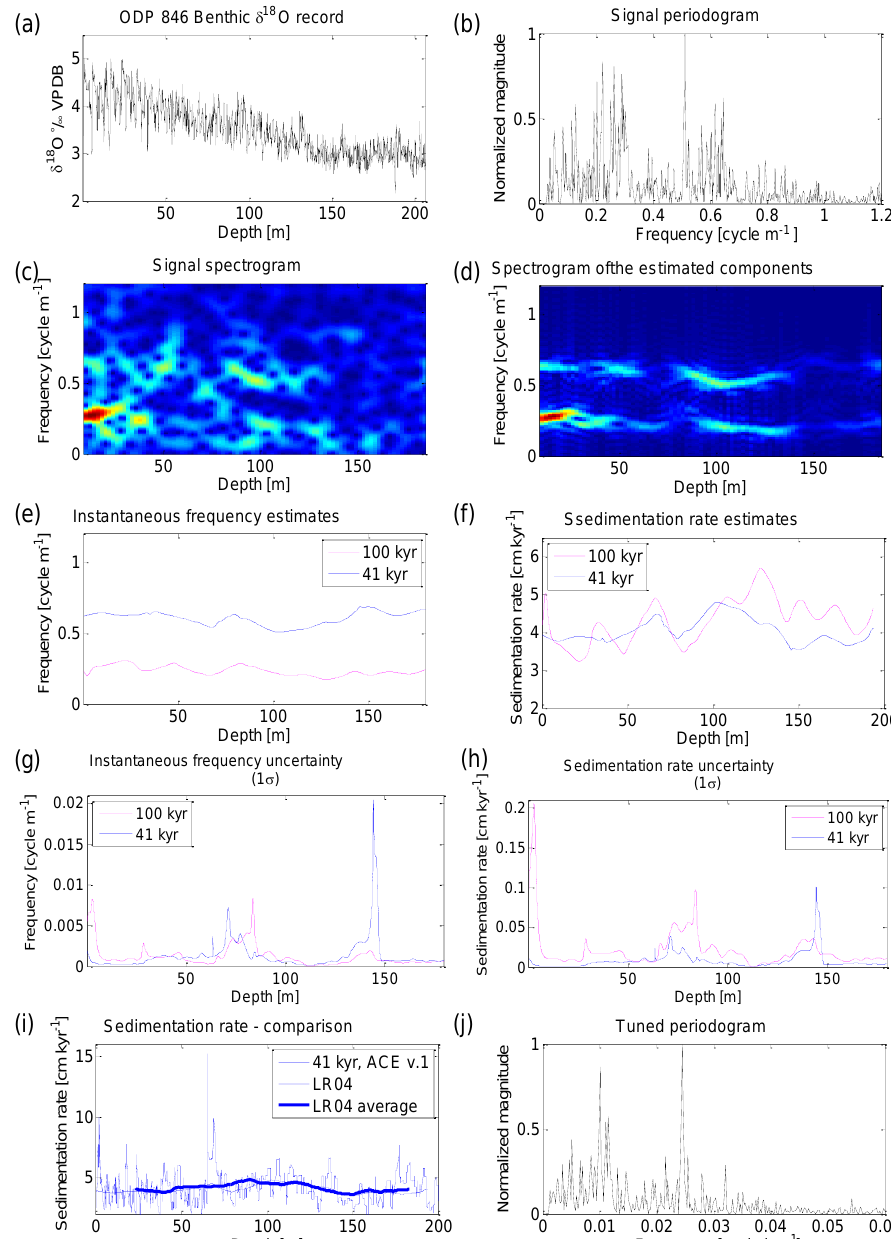
Figure 3. ACE v.1 analysis for a Pliocene–Pleistocene benthic oxygen isotope record. (a) ODP Site 846 δ 18 O record (Wm − 2 ) (Mix et al., 1995; Shackleton et al., 1995). (b) The periodogram of the ODP Site 846 δ 18 O record as plotted in Fig. 2a. (c) The spectrogram of the ODP Site 846 δ 18 O record. (d) The spectrogram of the two modeled components (100kyr periodicity and 41kyr obliquity) using ACE v.1. (e) Estimated instantaneous frequencies for the two modeled components. (f) Using the associated (astronomical) periods of the modeled frequencies, the corresponding sedimentation rate is calculated. (g) The uncertainties on the estimated instantaneous frequencies (1 σ) . (h) The uncertainties on the sedimentation rate estimates (1 σ) . (i) Comparison between the ACE v.1 estimated sedimentation rate and the derived non-averaged and 500-point-averaged sedimentation rates for ODP Site 846 according to the age model of the LR04 stack (Lisiecki and Raymo, 2005) and the estimated change in sedimentation rate based on the modeled obliquity component. (j) Periodogram of time series of the signal where the mean sedimentation rate estimate is used to make the conversion to the time